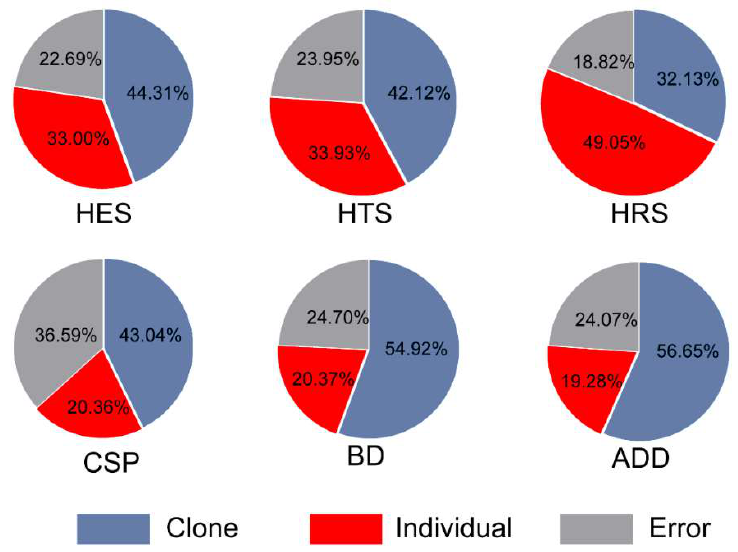
Figure 1. Variance component proportions of wood properties.